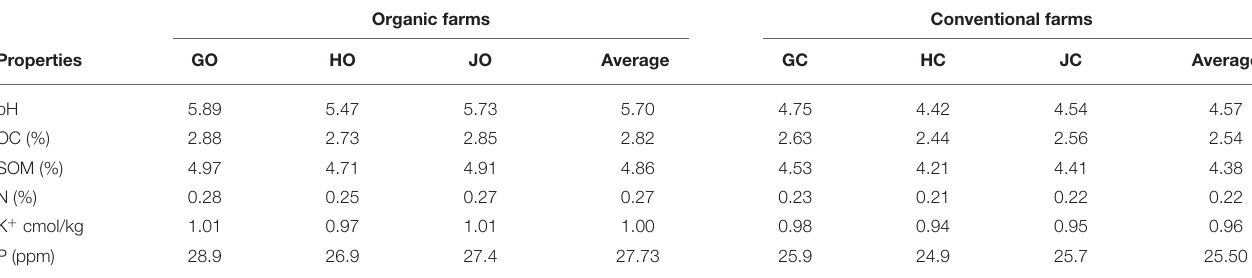
TABLE 1 | Soil characteristics in organic and conventional farms during the experimental period. Organic farms